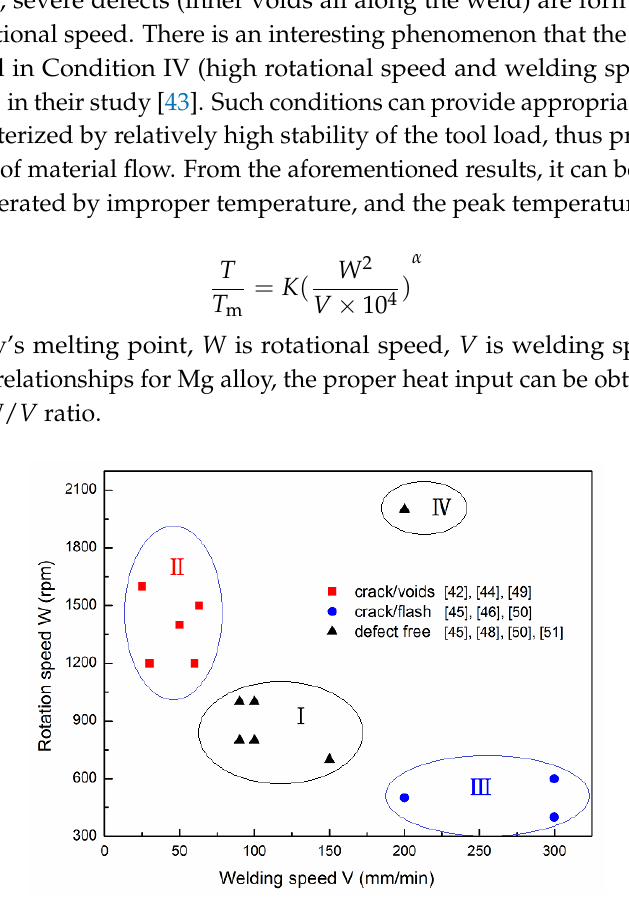
Figure 3. Relationship between the macro-defects and the welding parameters.